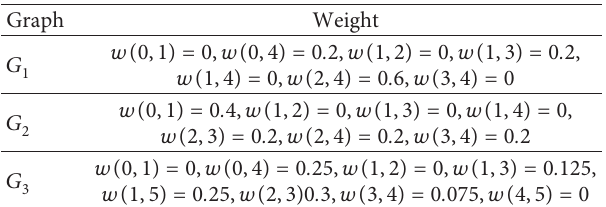
Table 2: Optimal weight assignment for minimizing Randi´c indices of graphs in Figure 1.